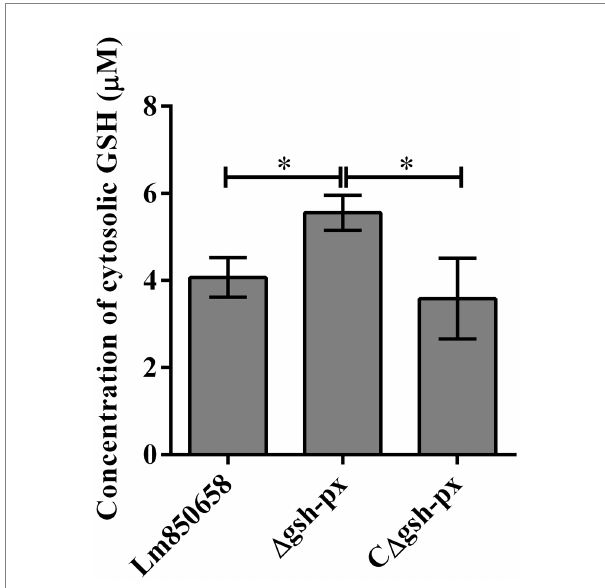
FIGURE 7 Deletion of gsh-px increased the glutathione levels in L. monocytogenes . Lm850658, Δ gsh-px and C Δ gsh-px were collected and lysed with lysozyme for 30 min. The concentrations of GSH